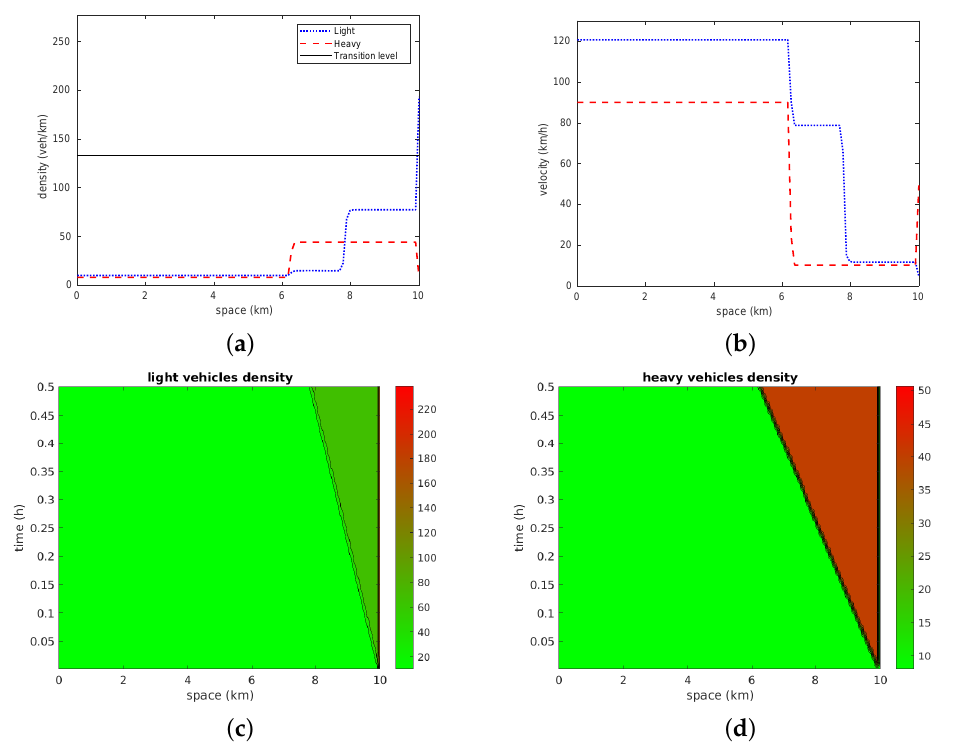
Figure 13. Test 2A: ( a ) Density and ( b ) velocity of light and heavy vehicles as a function of space at final time. ( c ) Density of light and ( d ) heavy vehicles in space–time.